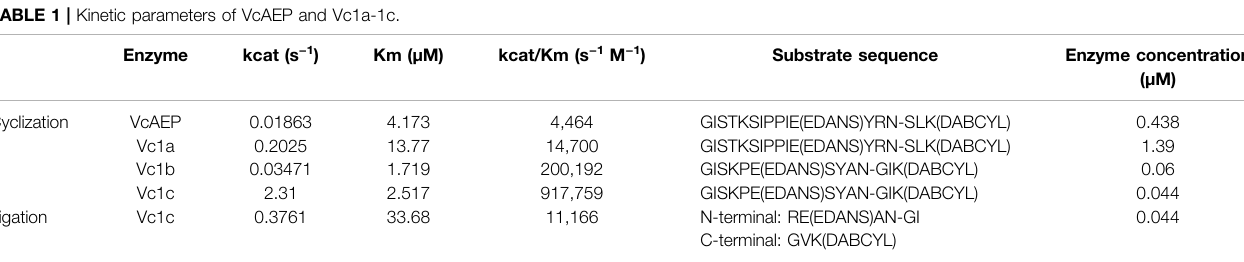
TABLE 1 | Kinetic parameters of VcAEP and